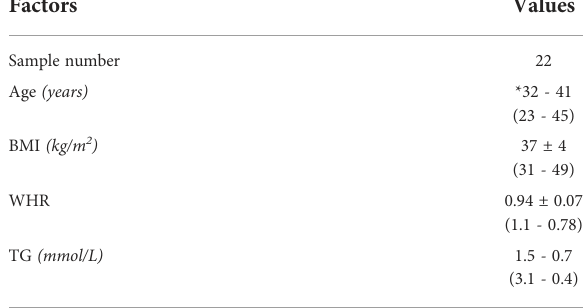
TABLE 3 Clinical parameters of cohort 3.